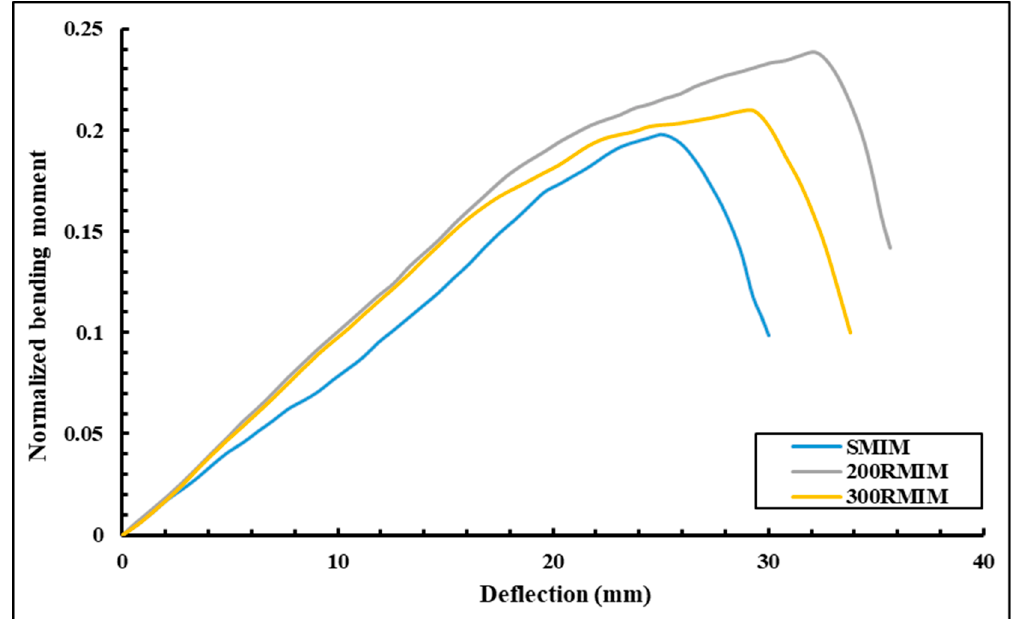
Figure 20. The normalized minor axis average curves.